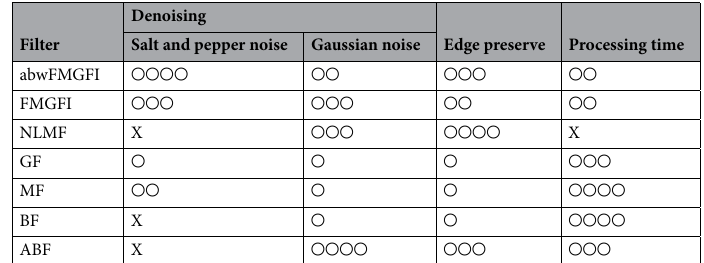
Table 19. Comparison of filter performances considering quantitative and qualitative evaluations.